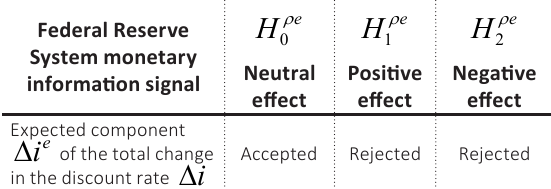
Table 5. Testing results for advanced hypotheses